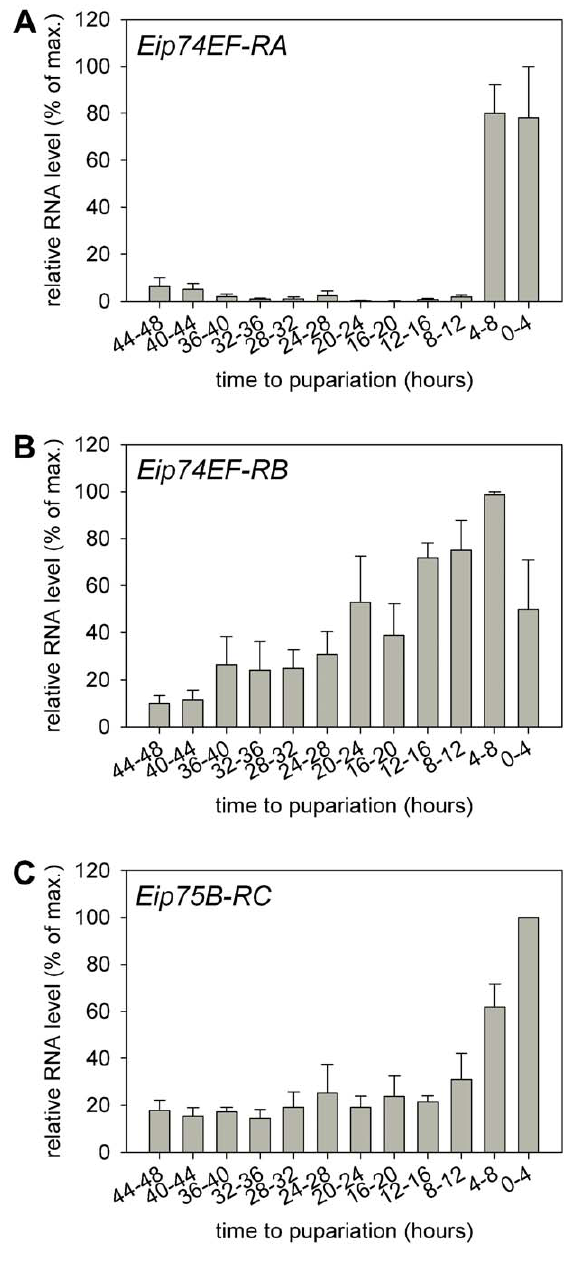
Figure 2. Transcriptional activity of Eip74EF and Eip75B promoters during the third larval instar. Transcript levels from the Eip74EF-RA (A), Eip74EF-RB (B) and Eip75B-RC (C) promoters in w 1118 larvae are shown. The charts show the average of relative RNA levels in percent of the maximum RNA quantity measured with the given primer pairs, the error bars indicate the standard